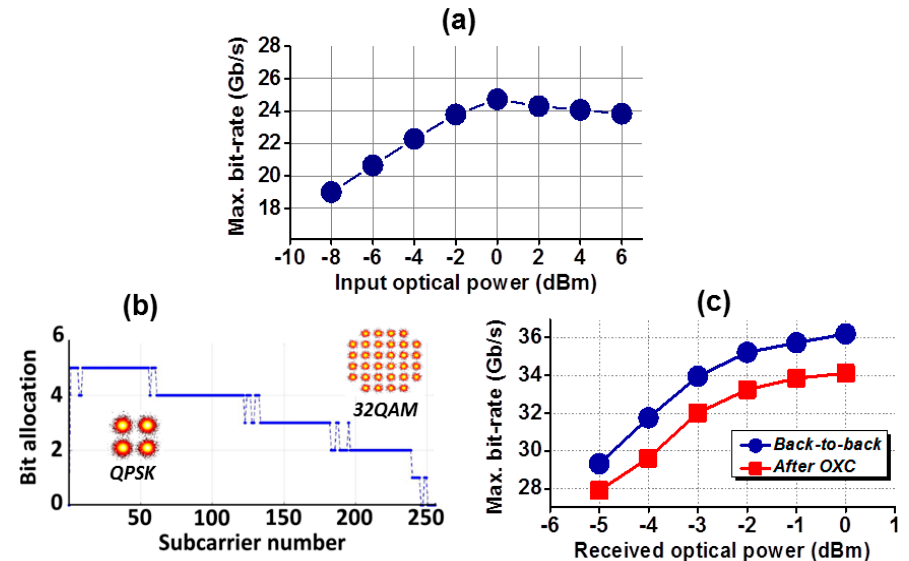
Figure 15. ( a ) Optimal input power; ( b ) bit allocation per subcarrier; and ( c ) maximum data-rate with different received optical powers for DMT traffic.